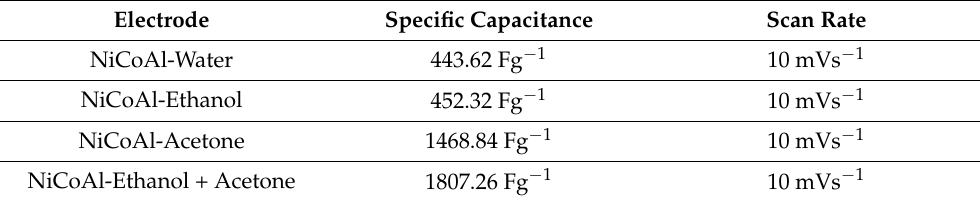
Table 5. Calculated specific capacitances for NiCoAl-Water, NiCoAl-Ethanol, NiCoAl-Acetone, and NiCoAl-Ethanol + Acetone.